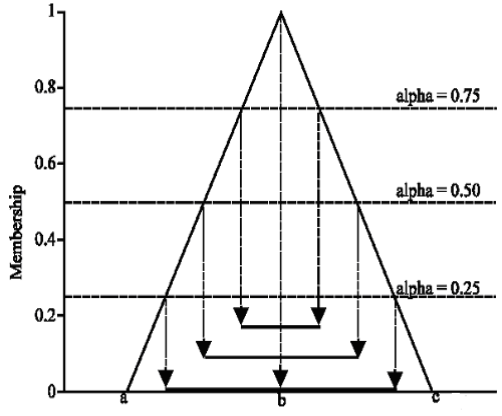
Fig 3. Triangular fuzzy parameter and its 